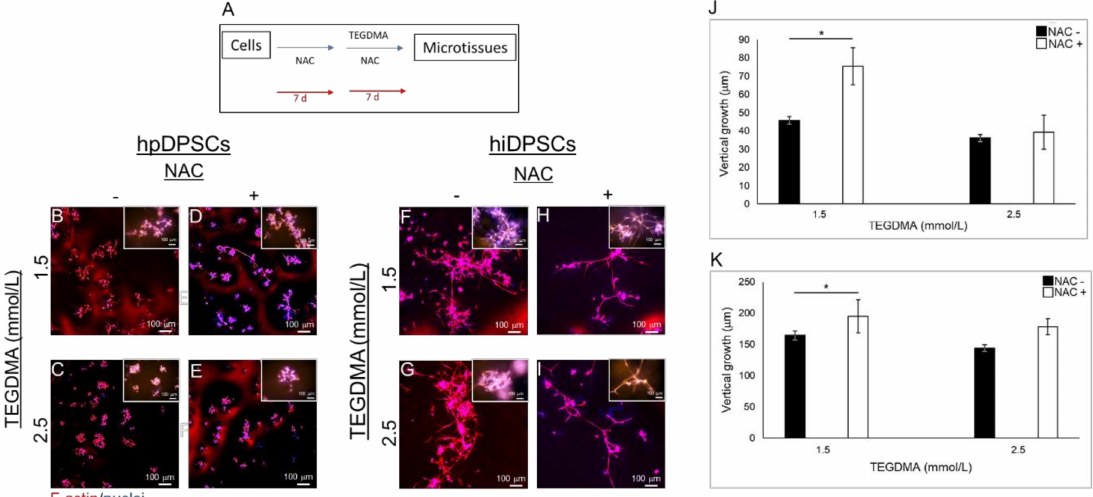
Figure A1. The spatial morphology of developing microtissues treated with NAC prior exposure to TEGDMA. ( A ) Schematic diagram of the experimental assay. ( B – I ) Confocal images of ( B – E ) hpDPSC and ( F – I ) hiDPSC microtissues ( B , C , F , G ) non-treated and ( D , E , H , I ) treated with NAC before exposed to ( B , D , F , H ) moderate and ( C , E , G , I ) high concentrations of TEGDMA. ( J – K ) Bar graphs compare